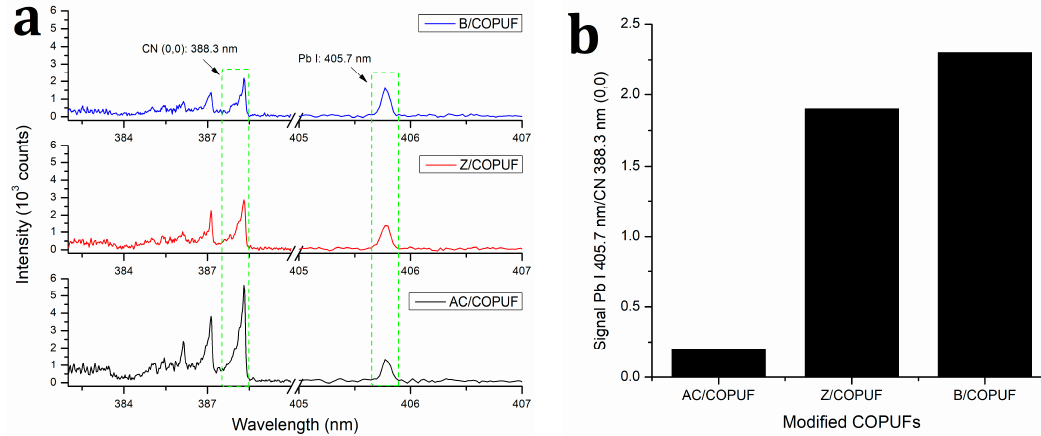
Figure 7. ( a ) LIBS spectra and ( b ) Pb I 405.7 nm / CN 388.3 nm (0,0) peak signal ratio of AC / COPUF, Z / COPUF, and B / COPUF after Pb 2 + adsorption, analyzed under high air pressure (760